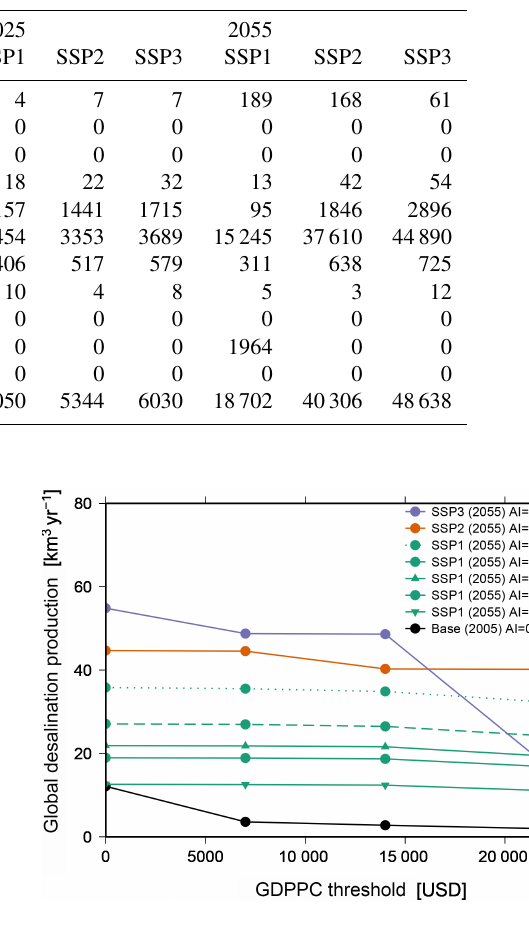
Figure 7. Sensitivity of GDP per capita (GDPPC; Condition A) and the aridity index (AI; Condition B) with respect to global to- tal production of seawater desalination. Black, blue, green, and red lines for base year (2005), SSP1, SSP2, and SSP3 in 2055, respec- tively. Solid, broken, and dotted lines for AI = 0.08, AI = 0.15, and AI = 0.2, respectively. The sensitivity of AI is only shown for SSP1 in